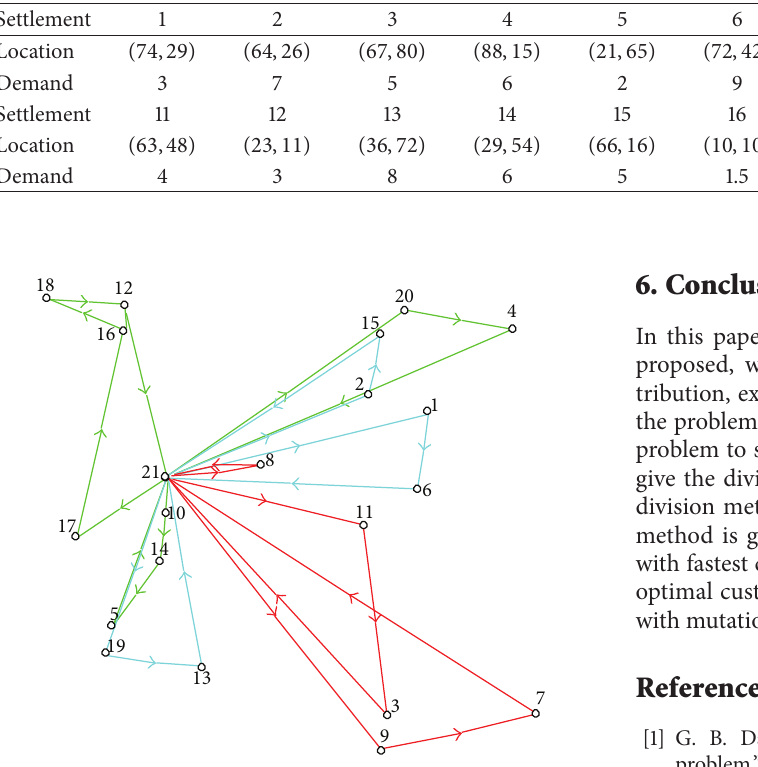
Figure 6: Optimal scheme of MRVRP with fastest completion time.